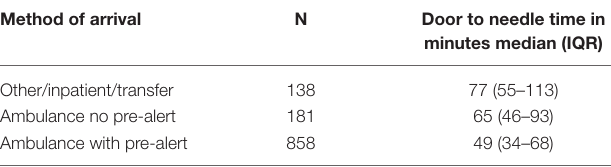
TABLE 3 | Door-to-needle time according to arrival method.